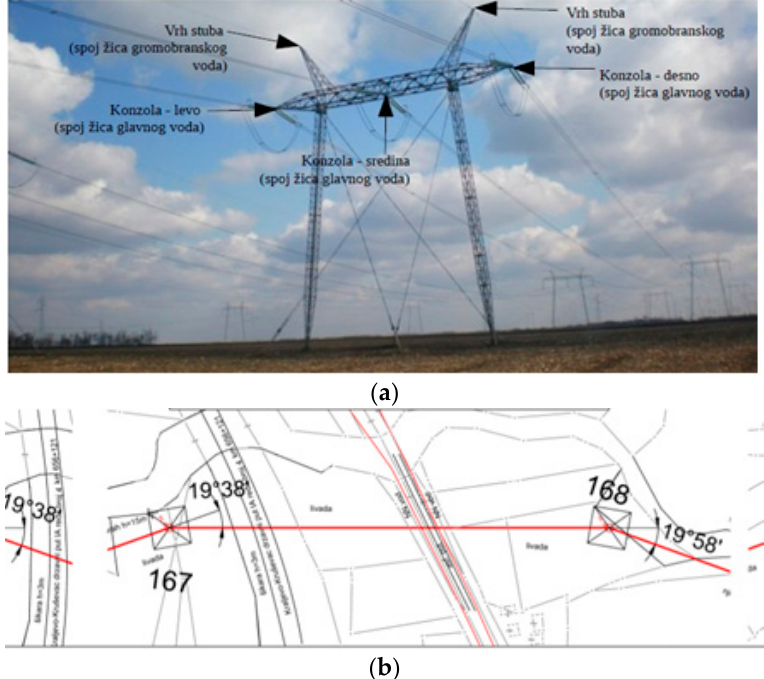
Figure 11. Powerlines. ( a ) A photo of a pole with powerlines; ( b ) a 2D representation of the powerlines.